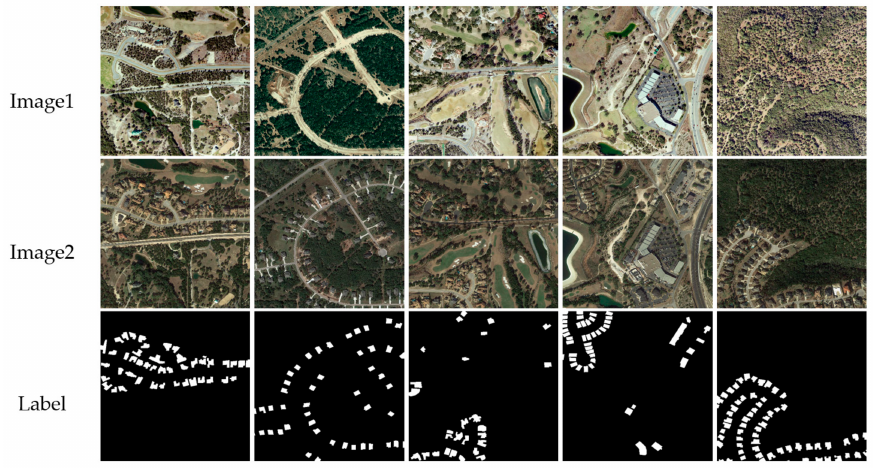
Figure 6. Example of bitemporal input and labels in LEVIR-CD.